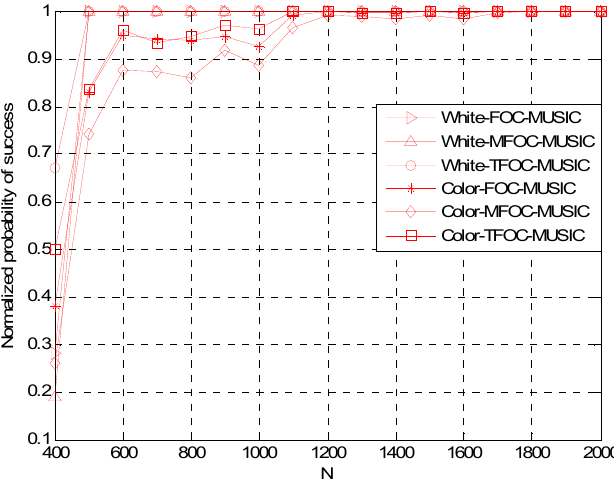
Figure 5. Normalized probability of success comparisons versus snapshots L .